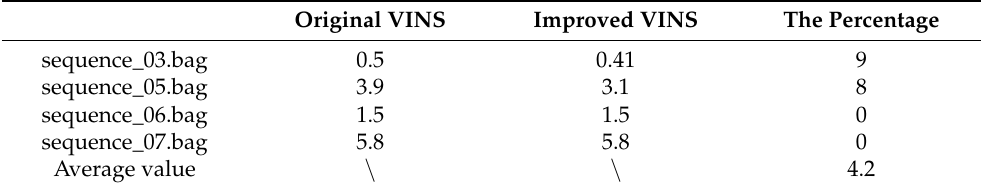
Table 15. Percentage of accuracy improvement between the original algorithm and the optimized algorithm in the underwater dataset (unit: